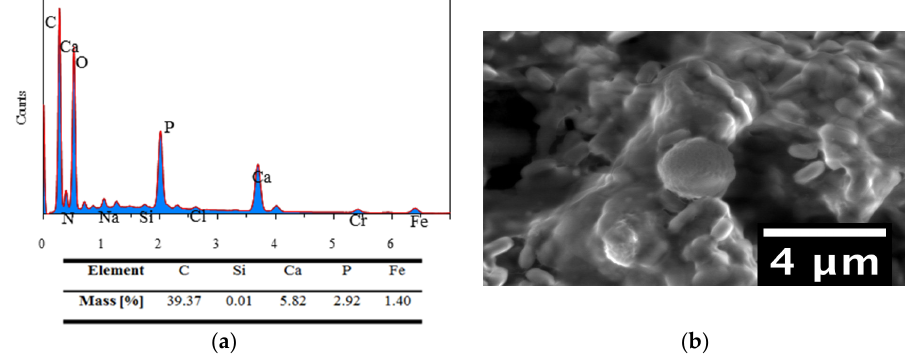
Figure 8. Energy dispersive spectroscopy (EDS)-spectrum ( a ) and the corresponding ESEM image ( b ) of a selected area of 45S5 BG/zein coating surface.